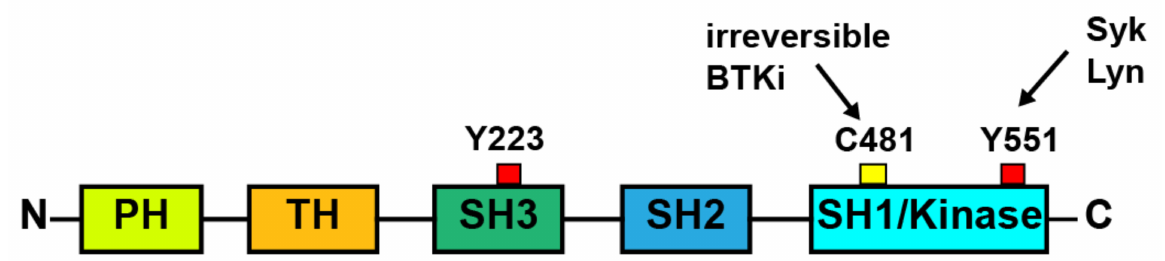
Figure 1. Schematic representation of the domain-structure of Btk . PH, pleckstrin homology; TH, Tec homology; SH, Src homology; the SH1 domain is identical to the kinase domain. Y223, autophosphorylation